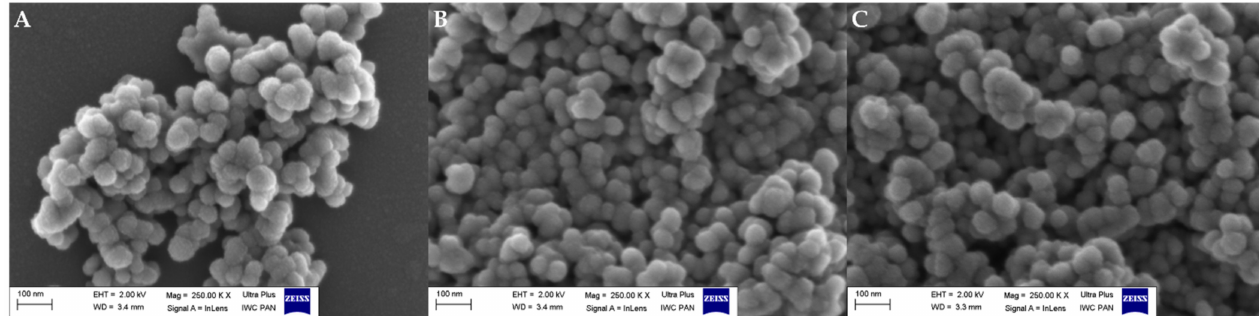
Figure 2. FE–SEM images of ( A ) ZnO NPs, ( B ) ZnO NPs–NH 2 –COOH–TRP, and ( C ) ZnO NPs–NH 2 –COOH–TRP–ELG.